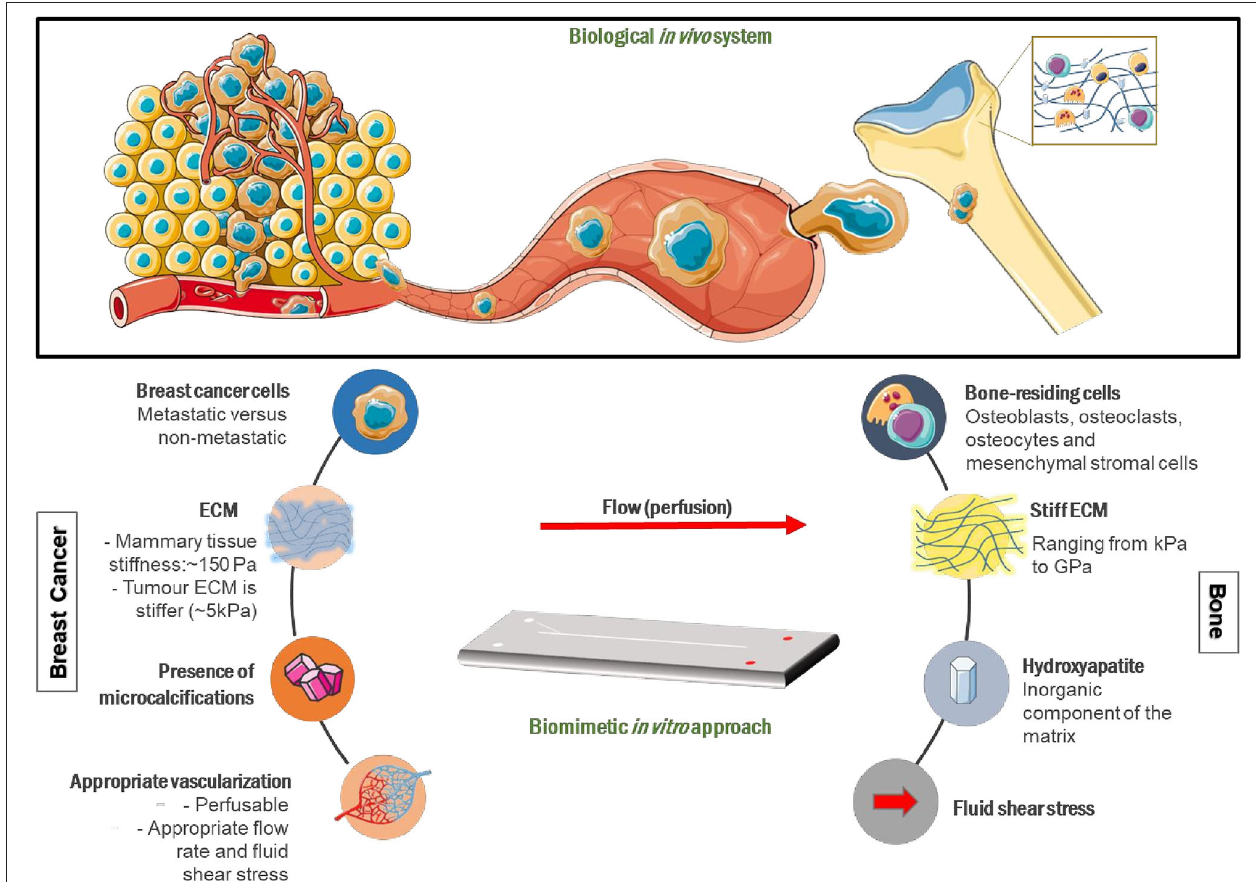
FIGURE 1 | Mechanobiological design considerations for metastasis-on-a-chip systems mimicking breast cancer metastasis to bone. Breast cancer cells (BCCs) invade the extracellular matrix (ECM), intravasate into blood vessels where they circulate in the vascular system before extravasating into a secondary site, in this case bone, where they grow into secondary tumors in vivo . A breast cancer-mimicking compartment should be made up of appropriate breast cancer cells and a surrounding ECM that will generate physiologically relevant matrix stiffness. A bone-mimicking compartment will consist of bone-residing cells, including mesenchymal stromal cells, osteoblasts, and osteoclasts, as well as key bone ECM components, such as hydroxyapatite. The ECM components included will define the elasticity, topography and chemistry of the matrix. Interconnected, physiologically relevant fluid flow between compartments will allow cancer cell migration to the secondary site and the formation of suitable cytokine/growth factor gradients. Portions of the schematic were produced using Servier Medical Art